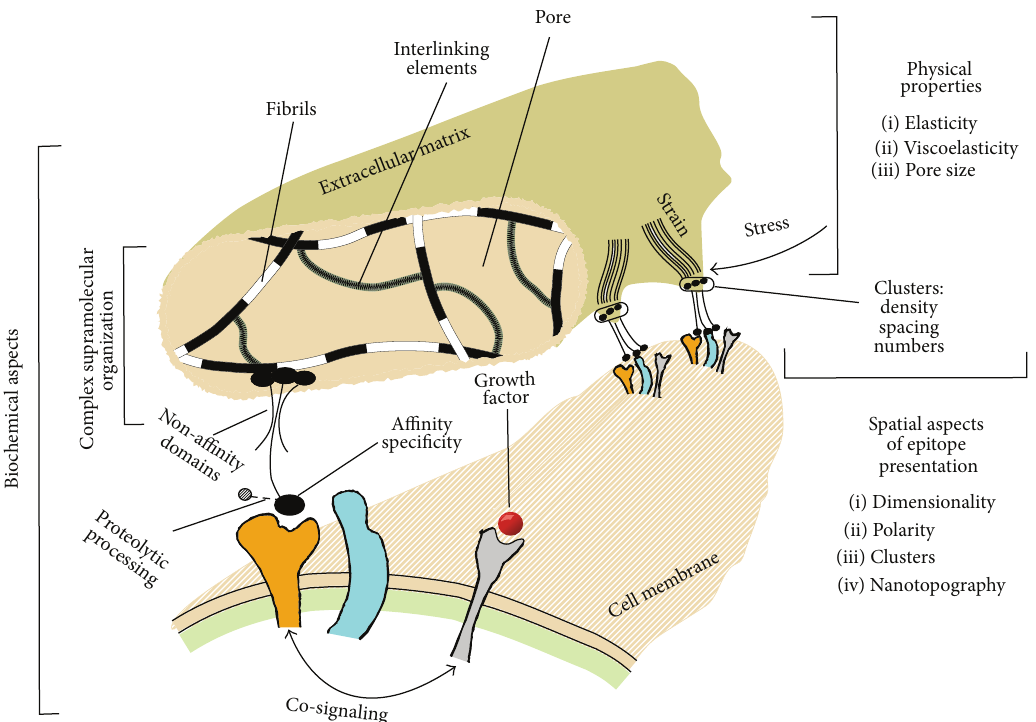
Figure 1: Physical, spatial, and molecular aspects of extracellular matrix that are known to affect stem cell behavioral patterns and choices . Extracellular matrix (ECM) of mammalian tissues in vivo is a complex structure composed of multiple molecular components, such as fibrils, fibril-associated crosslinking elements, and specific ligands interacting with cell receptors. Such molecular complexity has a biological reason, since lack of ECM molecules, due to mutation or knockout, often results in pathology or even mortality. Molecular composition of a matrix composition and the way of structural arrangement of the molecular components determine the physical, spatial, and molecular characteristics of the scaffold which, as we demonstrate in the review, may actively affect stem cells behavioral patterns. Physical aspects include stiffness (or elasticity); viscoelasticity; pore size and porosity; amplitude of static and dynamic deformations of the matrix (tensile, compressive, or shear); and frequency of cyclic deformations. Due to complex organization, elastic properties of the natural ECM cannot be characterized by a single parameter of Young’s modulus (which is valid for many synthetic gels). The stress-strain relation is often nonlinear and is described by stress-strain curve; the natural ECM tend to rearrange their structure under stress, which makes them viscoelastic and prone to plastic deformation. Viscoelastic materials change their elastic properties when they are subject to static strains or cyclic (dynamic) deformations; therefore, one has to take tensile characteristics of the system into account. Spatial arrangement includes dimensionality (2D or 3D) of the scaffold introduced to the cell; thickness of the substrate layer underlying the cell; cell polarity; surface area and geometry of adhesion surface; microscale topography of the surface; epitope concentration; epitope clustering characteristics (number of epitopes per cluster, spacing between epitopes within cluster, spacing between separate clusters, cluster patterns, and order or disorder in epitope arrangement); size, shape, and level of disorder of nanotopographical features such as fibers diameter and orientation. Molecular properties concern structural complexity of ECM molecules, types of adhesion epitopes and corresponding receptors, co-signaling (cooperation of growth factor- and matrix-dependent receptors), and affinity